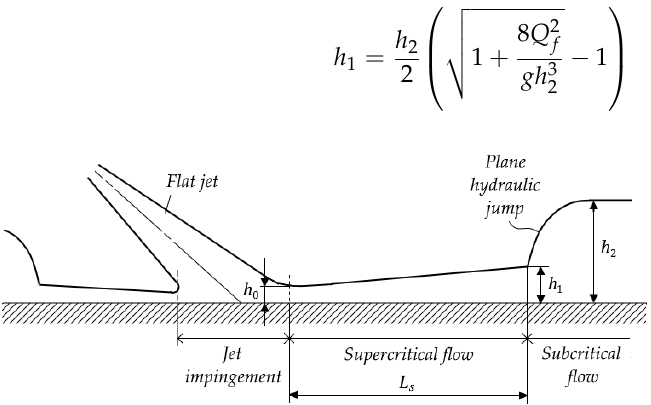
Figure 5. Schematic of the flow of a flat liquid jet on a horizontal plate with the formation of a plane hydraulic jump. The zones of jet impingement, supercritical and subcritical flow are shown.